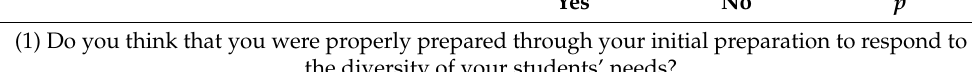
Table 2. Distribution of the three dichotomous questions according to sex.